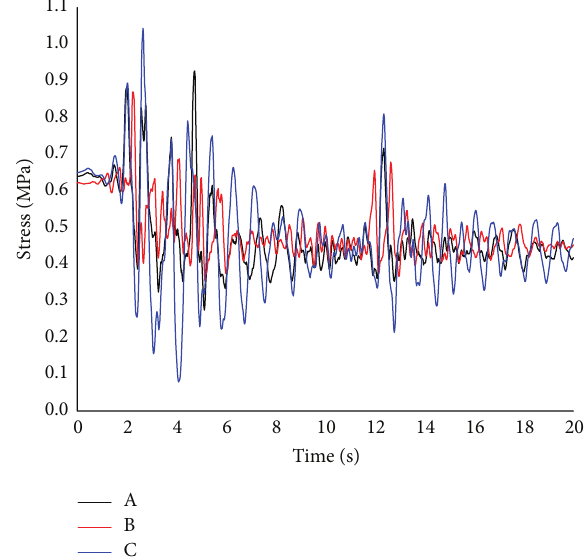
Figure 11: Maximum principal stress-time curves of monitoring points regardless of dynamic water